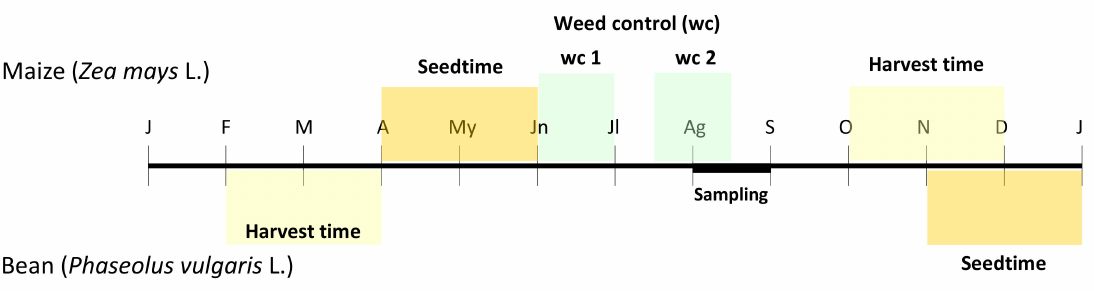
Figure 2. Maize–bean rotational cultivation system and sampling